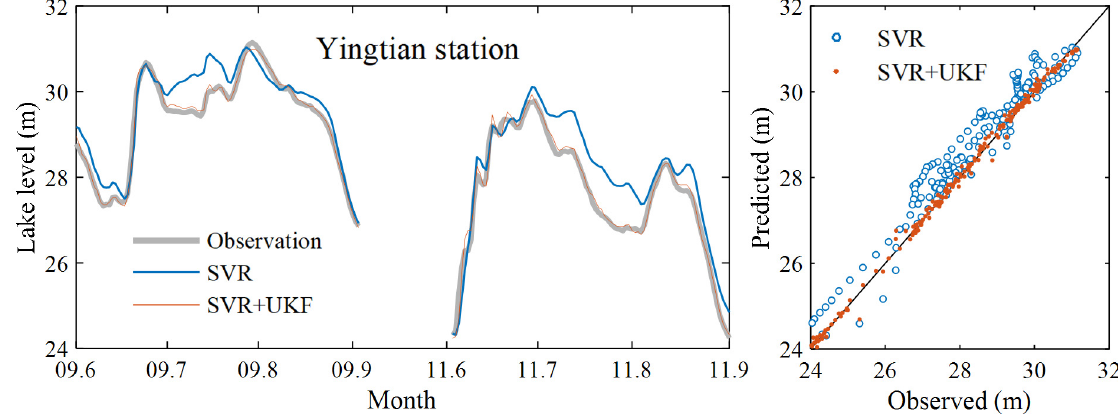
Figure 10. Comparisons between peak water levels in Yingtian predicted with SVR and SVR+UKF.